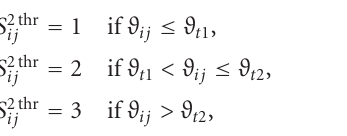
is present in images, we can also give quantitative definition of texture—for images corrupted by multiplicative noise in texture regions, σ 2 should be comparable or larger than σ 2 µ